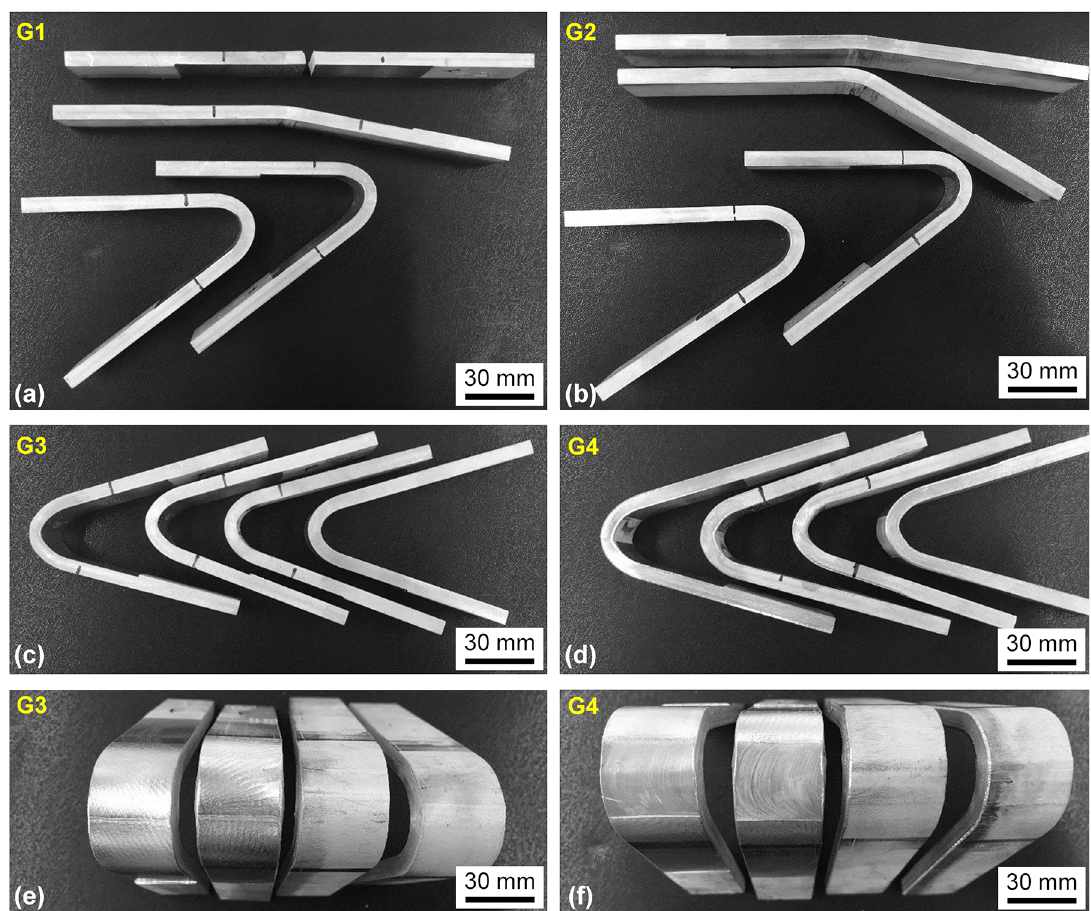
Figure 9. Welded samples after bending tests: (a) G1, (b) G2, (c) G3, and (d)